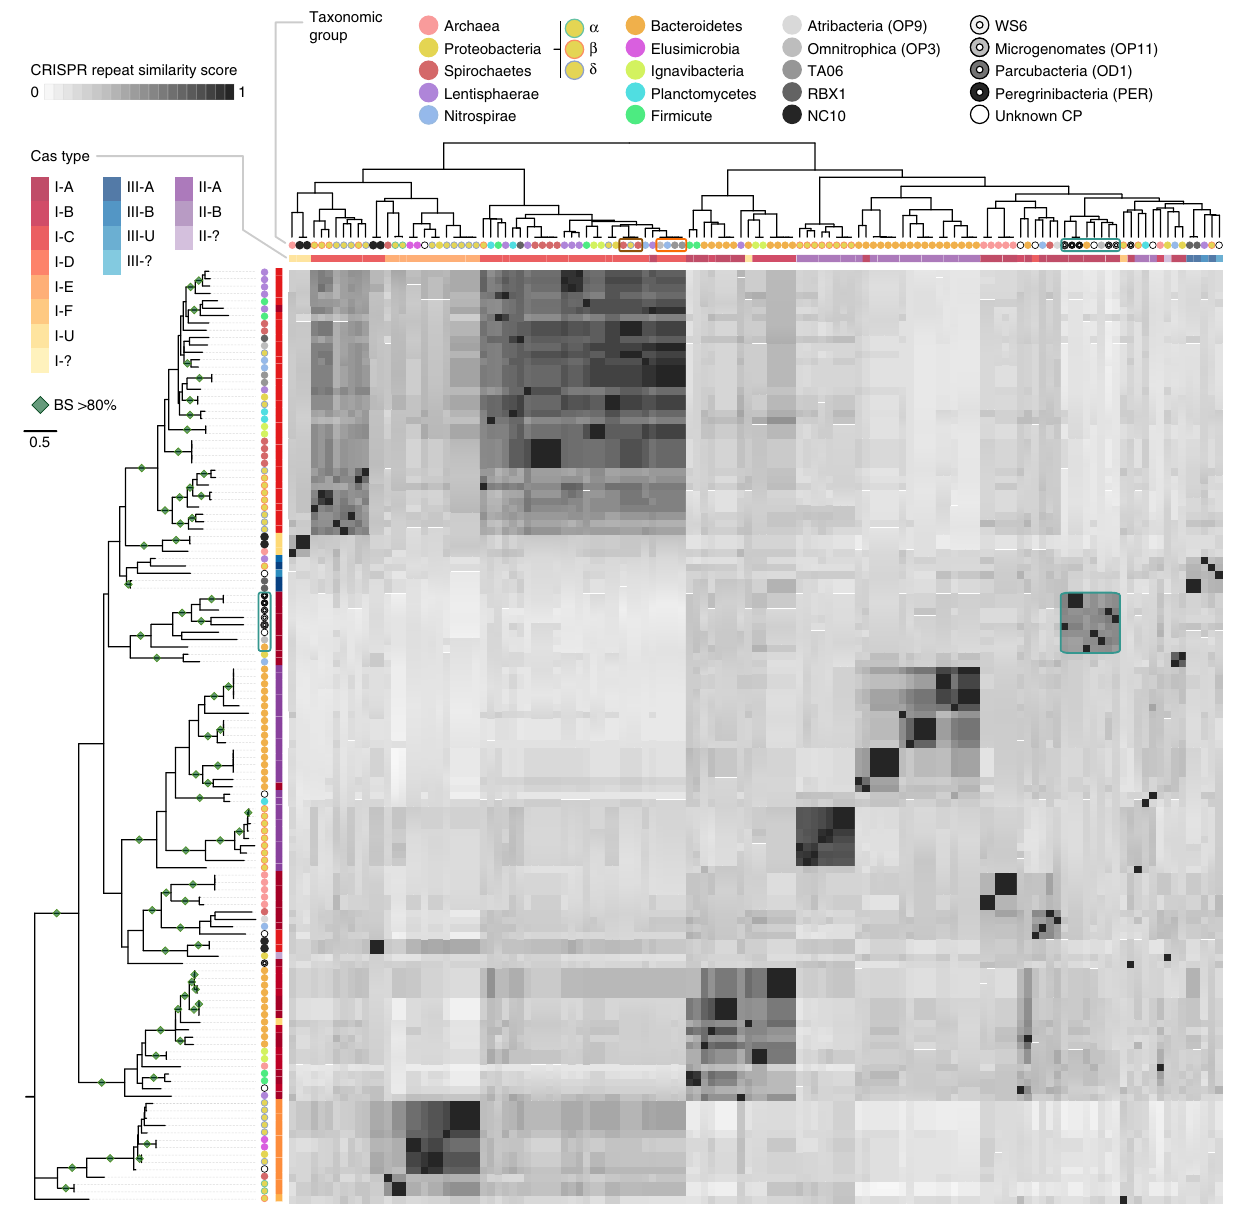
Figure 2 | Cas1 phylogeny versus repeat similarity in CRISPR-Cas retrieved from Rifle groundwater samples. Cas1 phylogeny (left) compared with the similarity of repeats in associated CRISPR arrays (top). Coloured circles on the branch tips represent taxonomic affiliation. Colour strip represent CRISPR-Cas type. Heat map shades correspond to full-length repeat similarity. Genomes from different phyla with identical repeats are marked by brown and orange boxes. The cyan box highlights a cluster of genomes with closely related Cas1 proteins and similar repeats, which includes one Bacteroidetes genome and most of the genomes from CPR organisms that have a CRISPR-Cas system. Green diamonds mark branching with bootstrap values (BS) 4